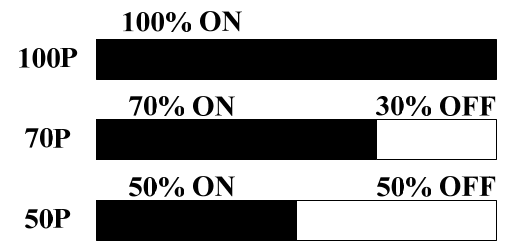
Figure 3. State diagram of microwave-based heating